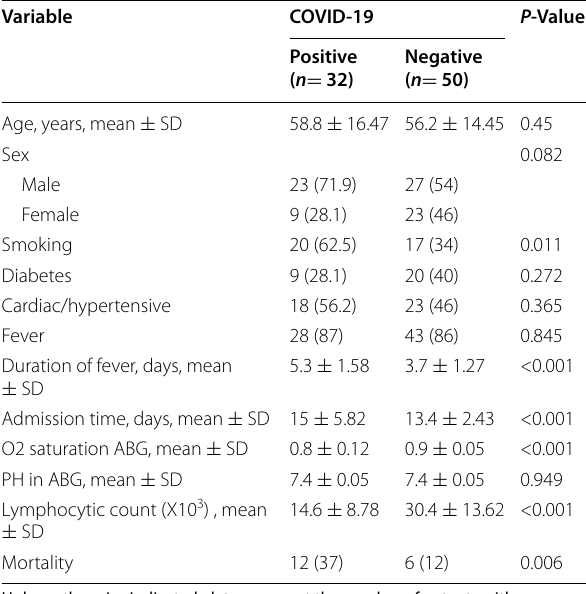
Table 1 The patients’ demographic and clinical